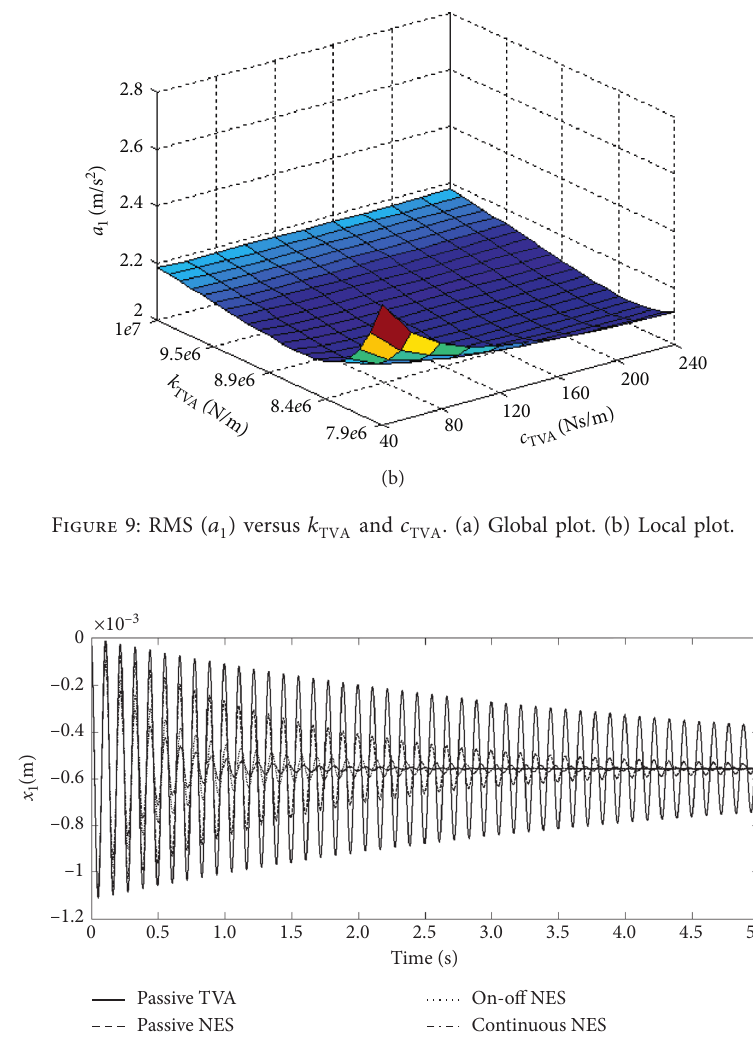
Figure 10: Displacement of main structure. Table 4: Summary of optimal parameters obtained with the periodic cutting force.